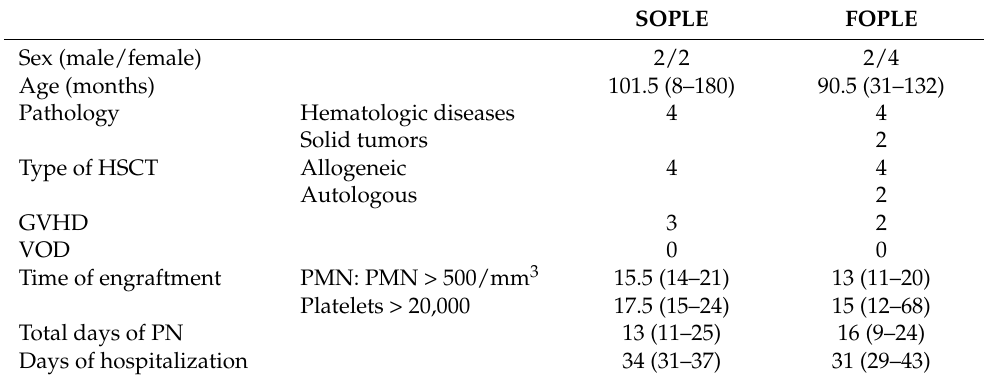
Table 1. Demographic characteristics and clinical complications in 10 children undergoing hematopoi- etic stem cell transplantation (HSCT) with two different lipid emulsions in parenteral nutrition, soybean oil, and n-3